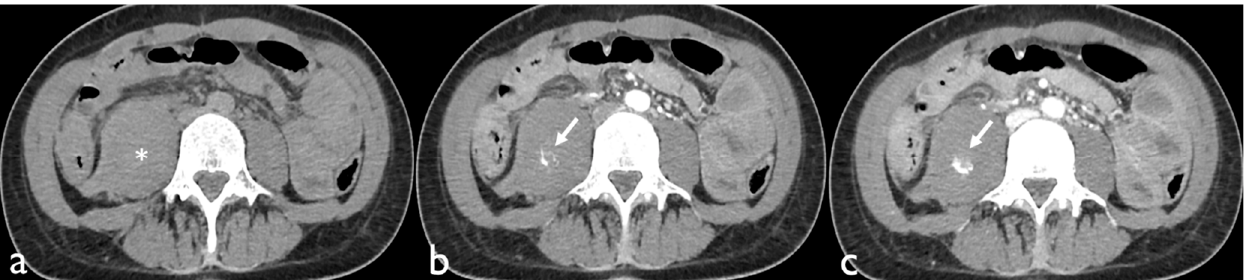
Figure 1. Non-contrast CT image ( a ) of a patient presenting with a hematoma of the right iliopsoas muscle extending into the retroperitoneal space (*). Contrast-enhanced axial CT images show active bleeding in the arterial ( b ) and portal phase ( c ).